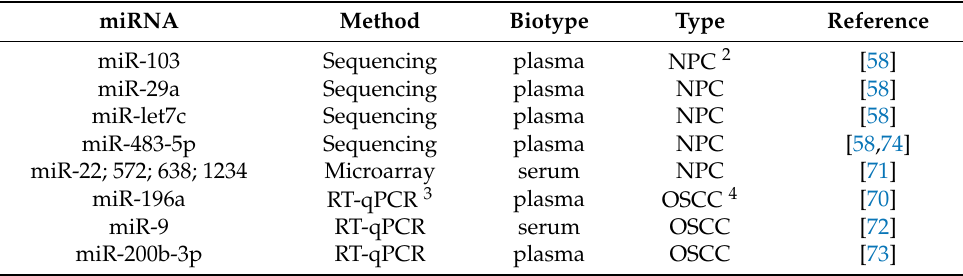
Table 2. Circulating miRNAs allowing prognostication of HNC 1